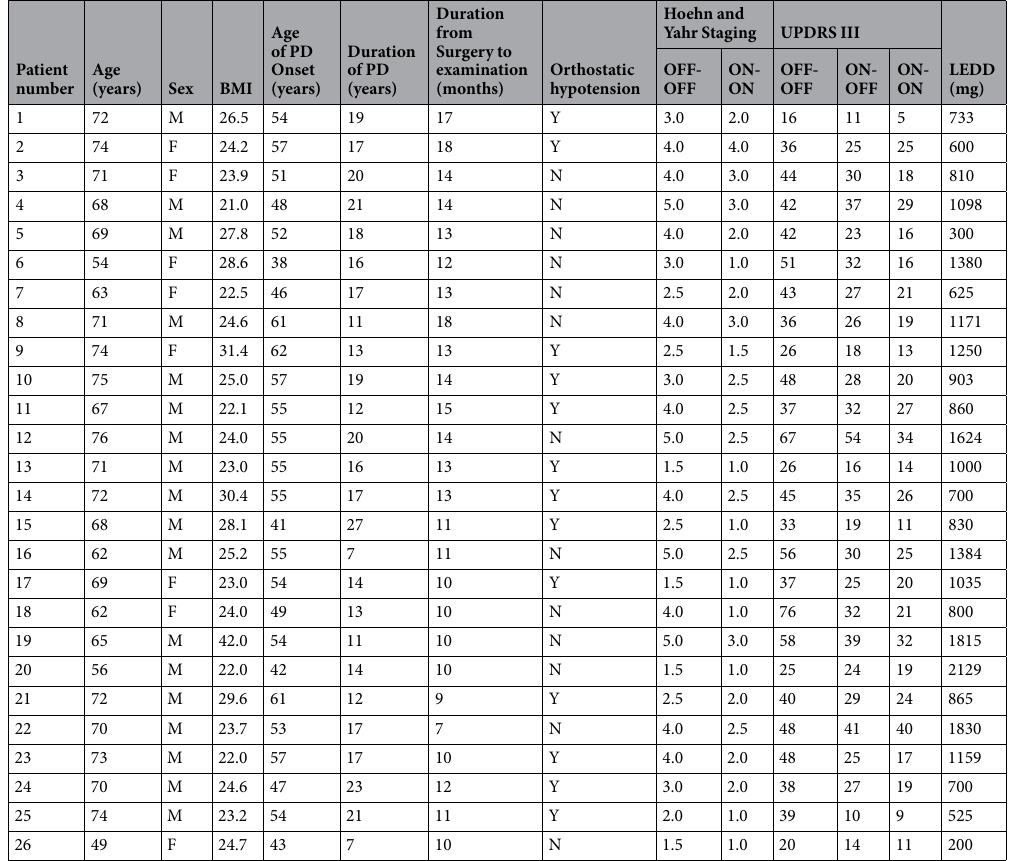
Table 1. Demographic and clinical characteristics of the patients with Parkinson’s disease. BMI = body mass index, F = female, M = male, LEDD = levodopa equivalent daily dose, PD = Parkinson’s disease, OFF- OFF = both off STN-DBS and off dopaminergic medication, ON-OFF = on STN-DBS and off dopaminergic medication, ON-ON = both on STN-DBS and on levodopa, UPDRS = Unified Parkinson’s Disease Rating